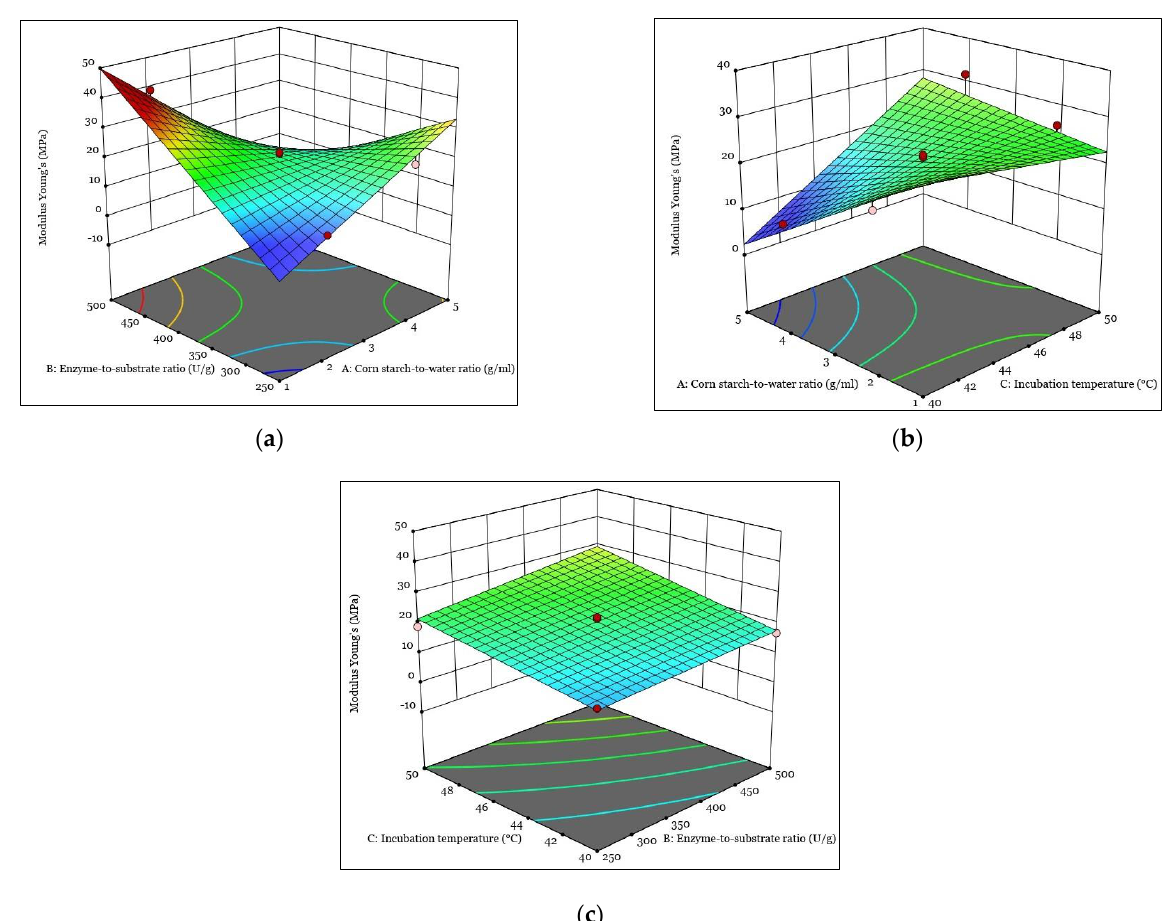
Figure 4. The response surfaces plots of the quadratic and 2FI polynomial models representing the influence of the interaction between independent variables on Young’s modulus: ( a ) interaction between A and B; ( b ) interaction between A and C; ( c ) interaction between B and C.